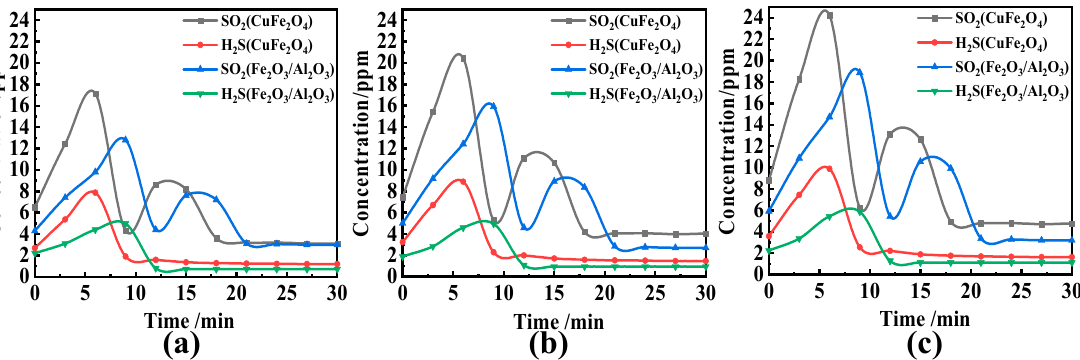
Figure 11. Trends of SO 2 and H 2 S over time during reduction using iron-based OC and CuFe 2 O 4 as OC in ( a ) 1st, ( b ) 5th and ( c ) 10th cyclic experiments.